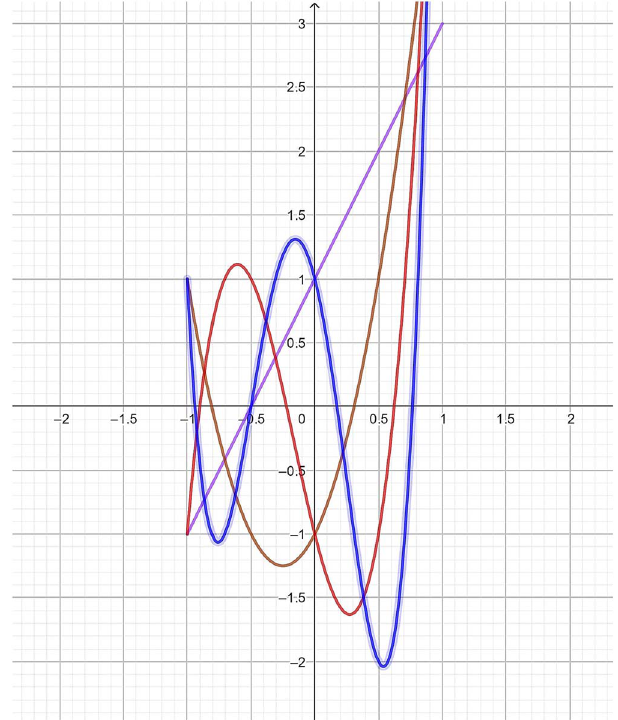
Figure 3. W k ( x ), k = 1, 2, 3, 4. (1) Violet; (2) brown; (3) red; (4)